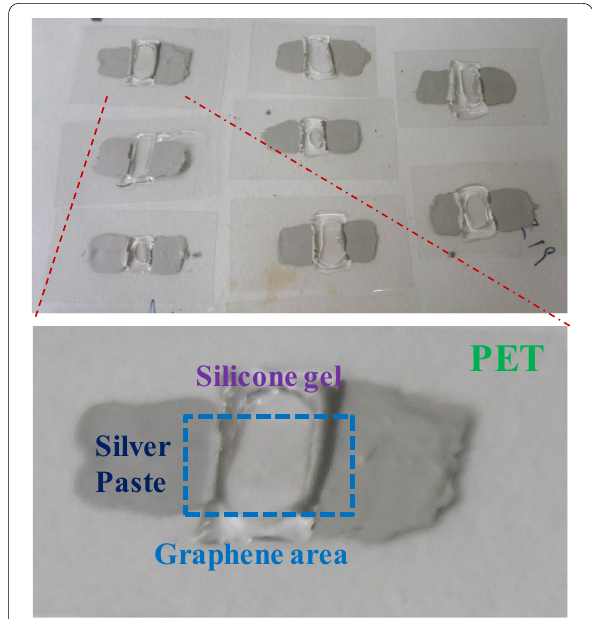
Fig. 2 Photograph of graphene/PET biosensor